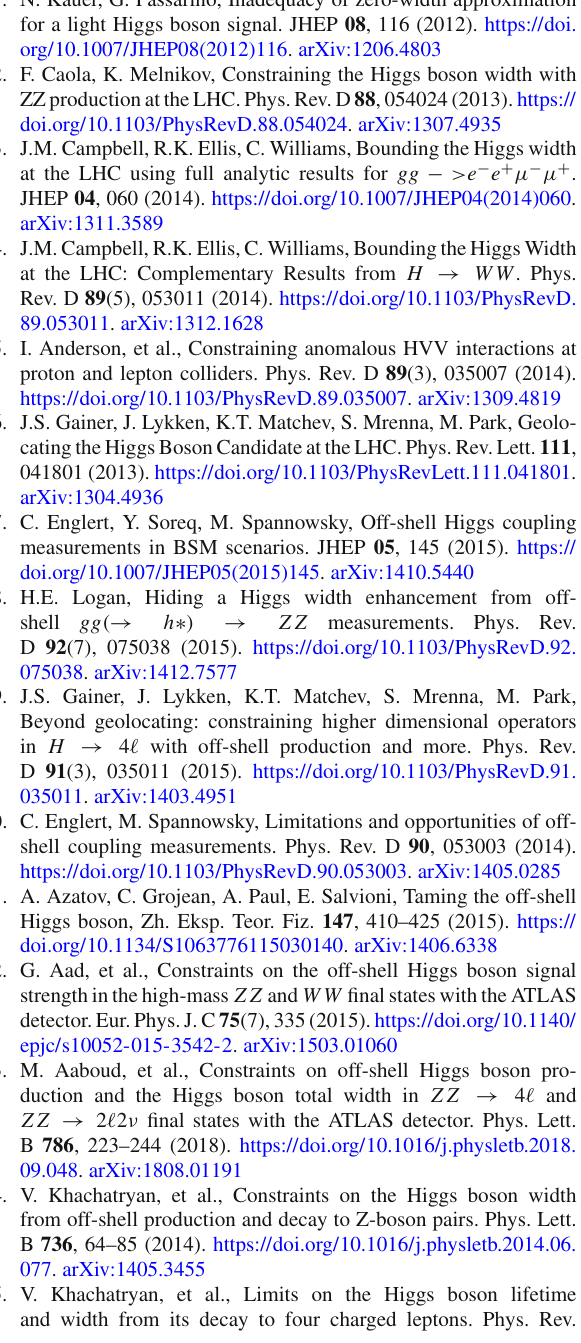
the 1 / m t expansion (exp, blue) for m 4 (cid:3) < 340 GeV,